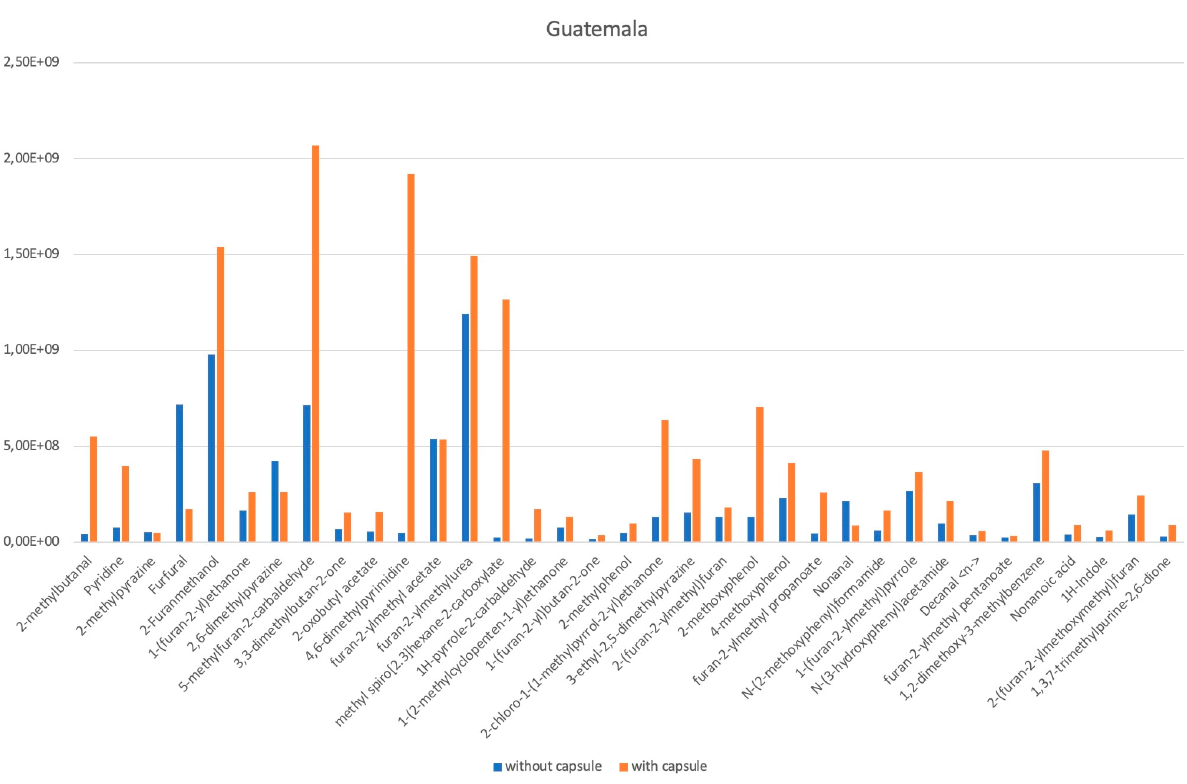
Figure 4. Comparison abundance value of common compound between Guatemala coffee “with capsule” and “without capsule”.